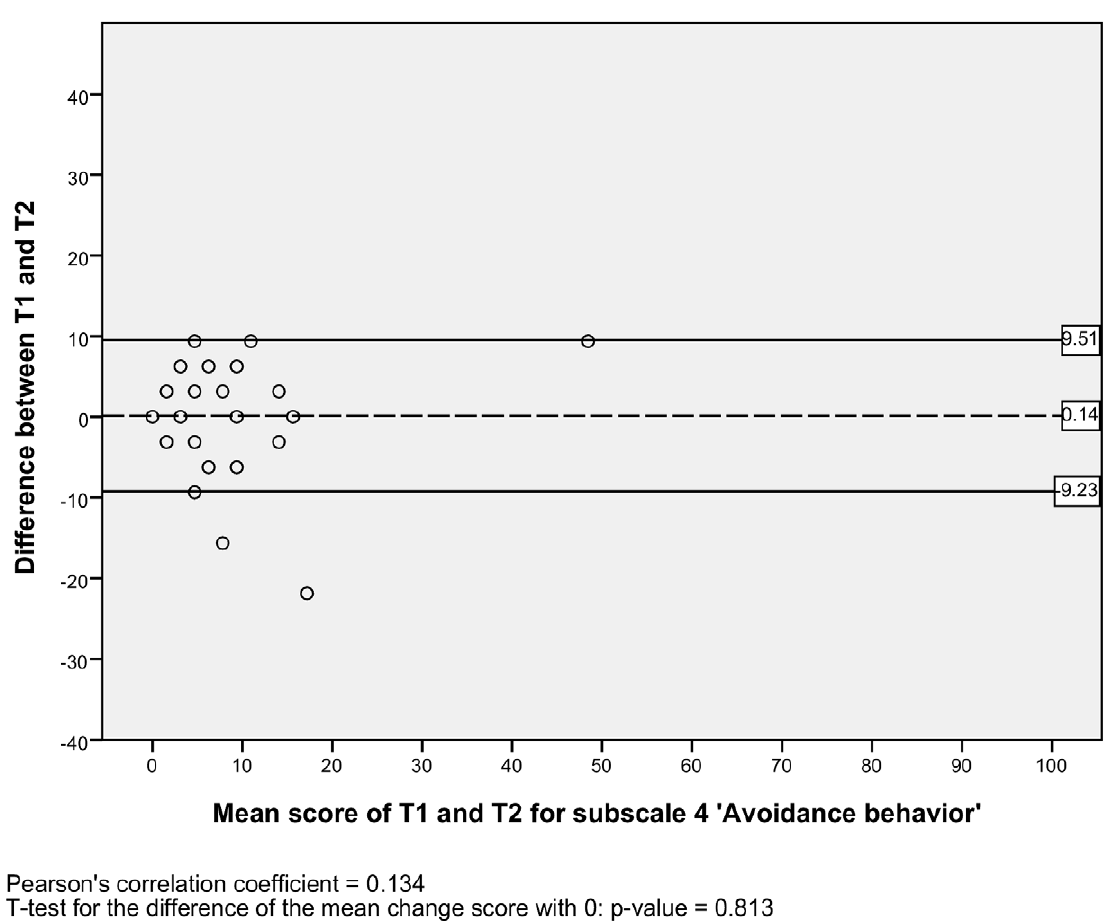
Figure 4. Bland and Altman plot for subscale 4 ‘Avoidance behavior’.